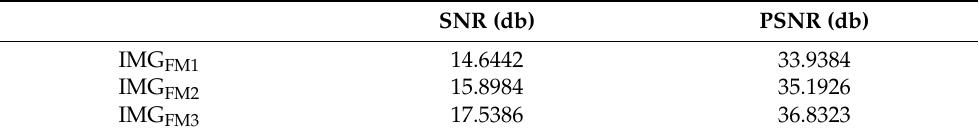
Table 8. Objective evaluation results 2 of image